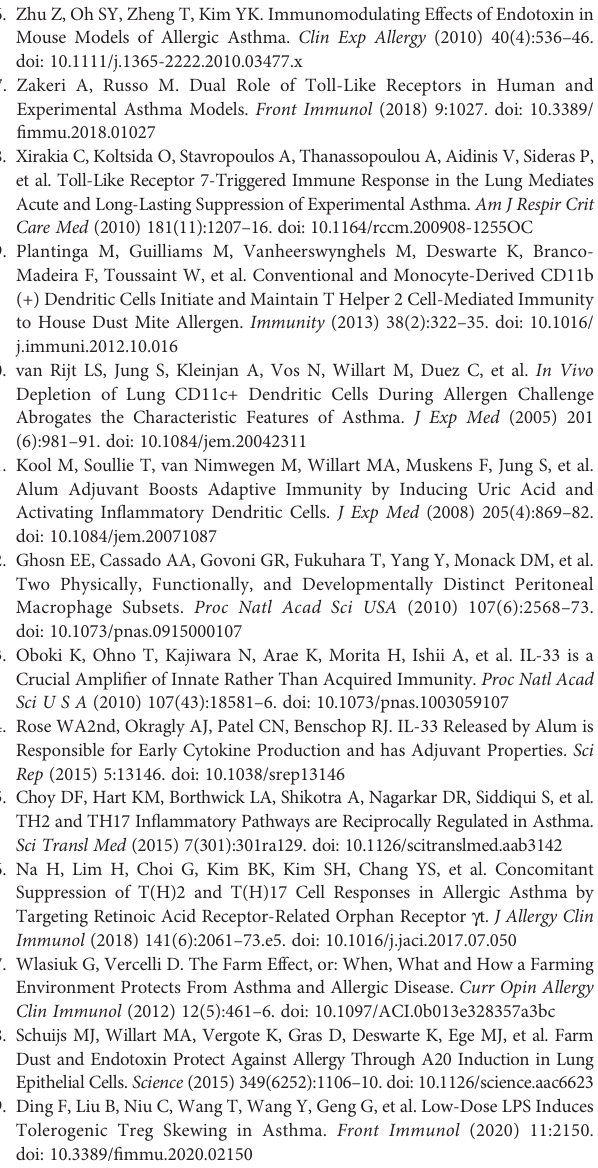
Supplementary Figure 2 | The expression of CD80, CD86 and OX40L on peripheral blood monocytes. Peripheral blood cells from naive mice of both ages were assessed by fl ow cytometry. (A) The gating strategy of blood monocyte. (B) The percentage of blood monocytes. (C) The expressions of CD80, CD86 and OX40L on blood monocytes. Data are representative of three independent experiments with n = 3 mice per group. Data are shown as mean ± SD. * P <